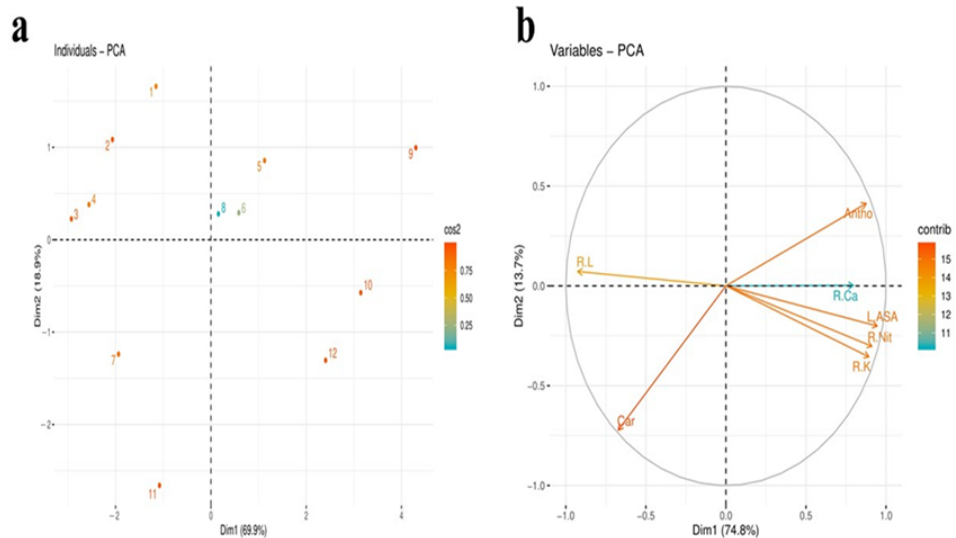
Figure 1. Score ( a ) and loading plot ( b ) of principal component analysis (PCA) on different attributes of maize cultivar Gohar-19 plants supplemented with and without SA while grown under B stress. Score plot represents the separation of treatments as T1: 0 mg B without SA; T2: 0 mg B with 50 µ M SA; T3: 0 mg B with 100 µ M SA; T4: 0 mg B with 150 µ M SA; T5: 15 mg / kg B without SA; T6: 15 mg / kg B with 50 µ M SA; T7: 15 mg / kg B with 100 µ M SA; T8: 15 mg / kg B with 150 µ M SA; T9: 30 mg / kg B without SA; T10: 30 mg / kg B with 50 µ M SA; T11: 30 mg / kg B with 100 µ M SA; T12: 30 mg / kg B